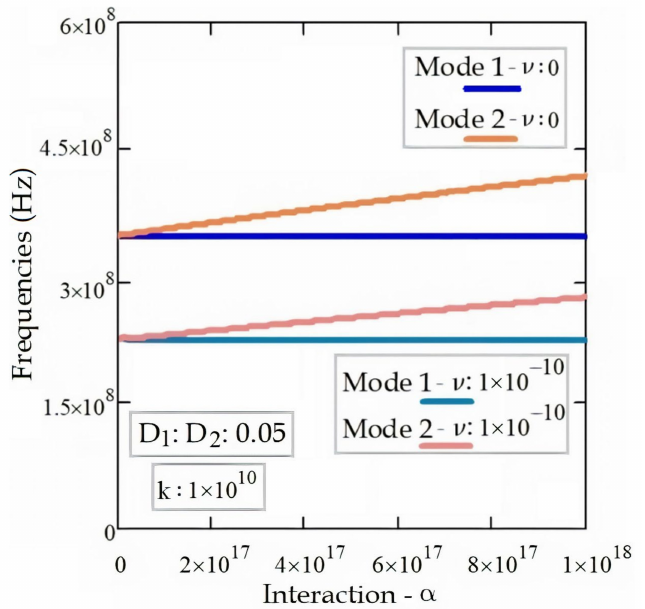
Figure 7. Frequencies of EM wave propagation in the DWT regarding the various interaction coefficients and nonlocal constants for ν : 0 and ν : 1 × 10 − 10 .